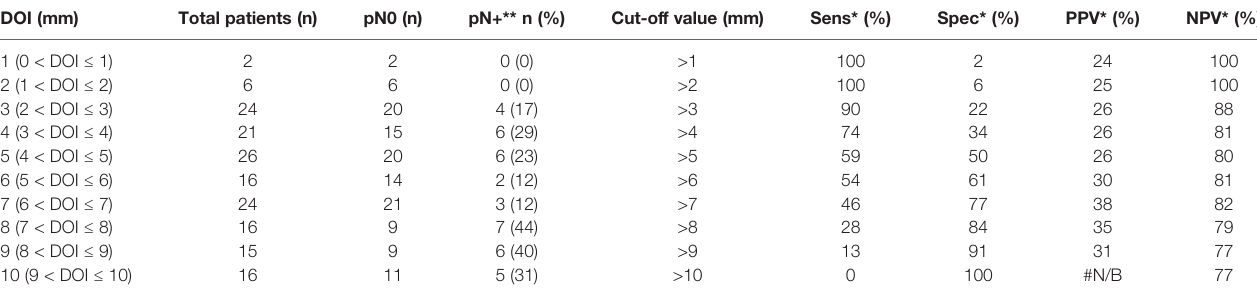
*Sensitivity, speci fi city, PPV, and NPV were calculated using the upper limit of the category as a cut-off. **Percentage is based on the pN+ per categorized DOI (mm).